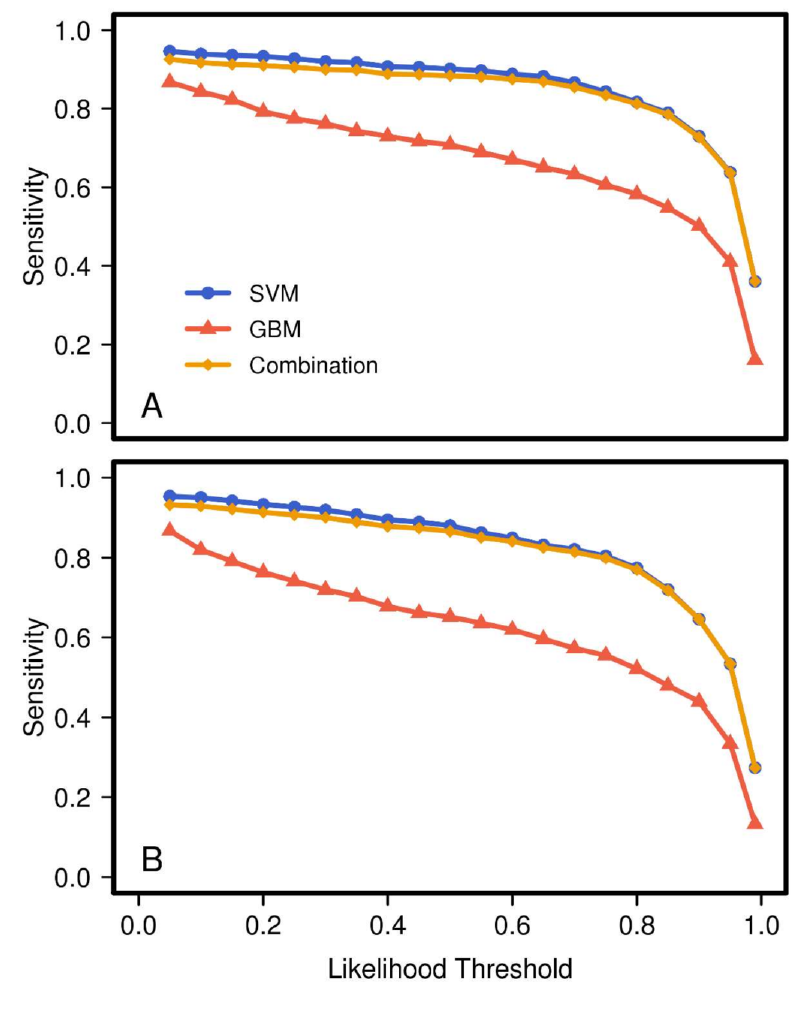
Figure 3. Effect of likelihood threshold selection on the proportion of training pixels from of a given class predicted to belong to the correct class (sensitivity) for both Brown ( A ) and Leafless ( B ) observed pixel classes, under the SVM, GBM, and combined models using a 10-fold cross-validation. Similarly, precision rapidly increased with T to >90% for all models in the range 0 to ca. 0.4 (Figure 4). However, compared to the values for sensitivity, the difference between models was not as large. The rate of precision for Brown pixels was lower for the GBM than for the SVM. However, with respect to Leafless pixels, the two models had nearly the same values for precision. We found the combined model not only kept the properties of the best of its component models, it improved upon them. Here, the combined model Brown pixel precision values most rapidly improve with increasing threshold, reaching a semi-plateau by a threshold value of 0.2. To a lesser degree the same was true for Leafless